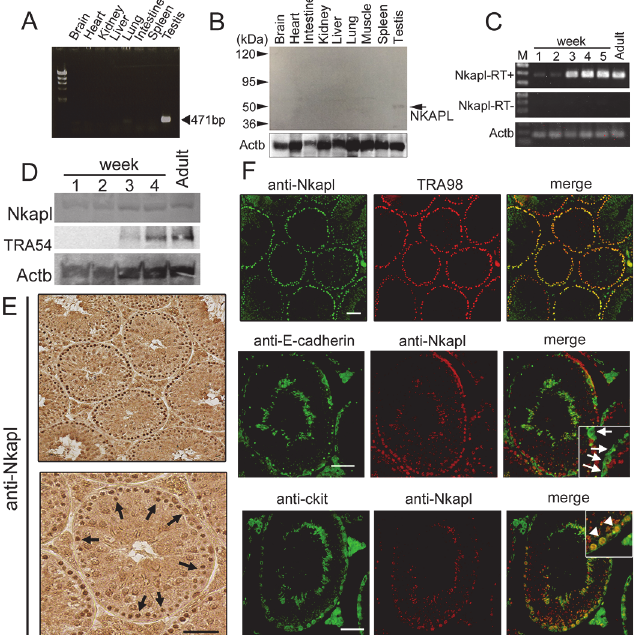
Fig 1. NKAPL expression and localization analyses. (A) RT-PCR analysis of systemic tissue. The targeted amplicon was 471 bp. (B) Immunoblotting analysis of systemic tissue protein. (C) RT-PCR analysis of testis by age. RT+ or RT- represents the presence or absence of reverse transcription, respectively. M: DNA size marker. (D) Immunoblotting of testis by age. (E) Immunohistochemistry of adult testis with Nkapl antibody. Black scale bar = 50 μ m. (F) Immunofluorescence of adult testis with Nkapl, TRA98, E-cadherin, and c-kit antibodies. White arrows indicate E-cadherin-positive undifferentiated spermatogonia, and white arrowheads represent c-kit-positive differentiating spermatogonia. White scale bar = 50 μ m.